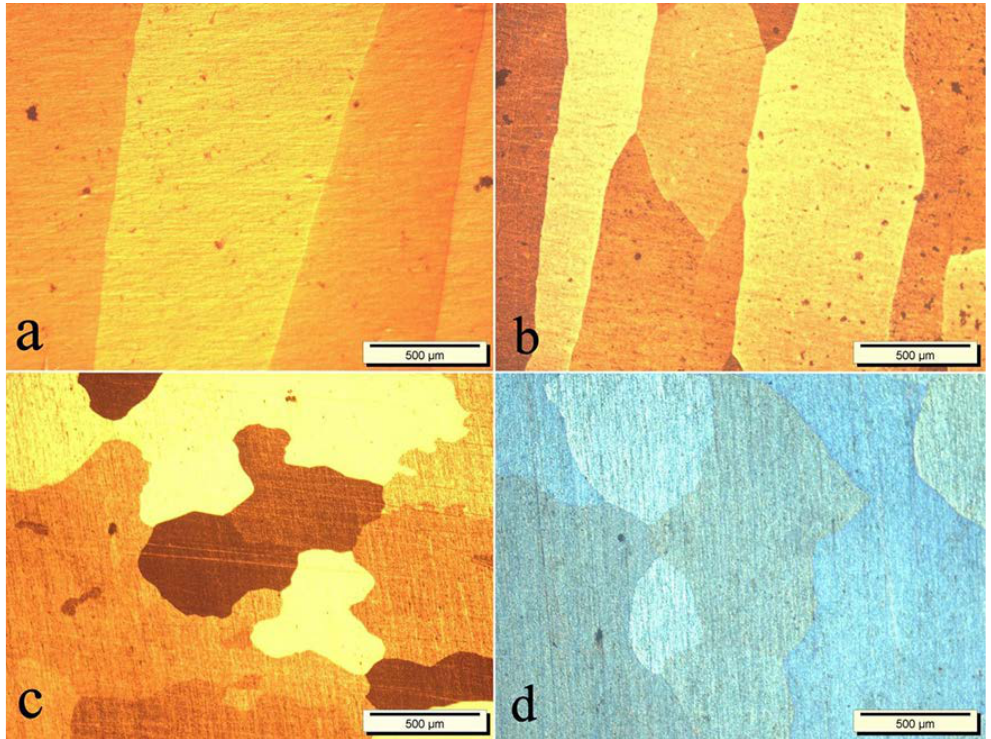
Figure 1. Microstructure as a function of solidification direction: (a) 0º SD, (b) 30º SD, (c) 60º SD, (d) 90º